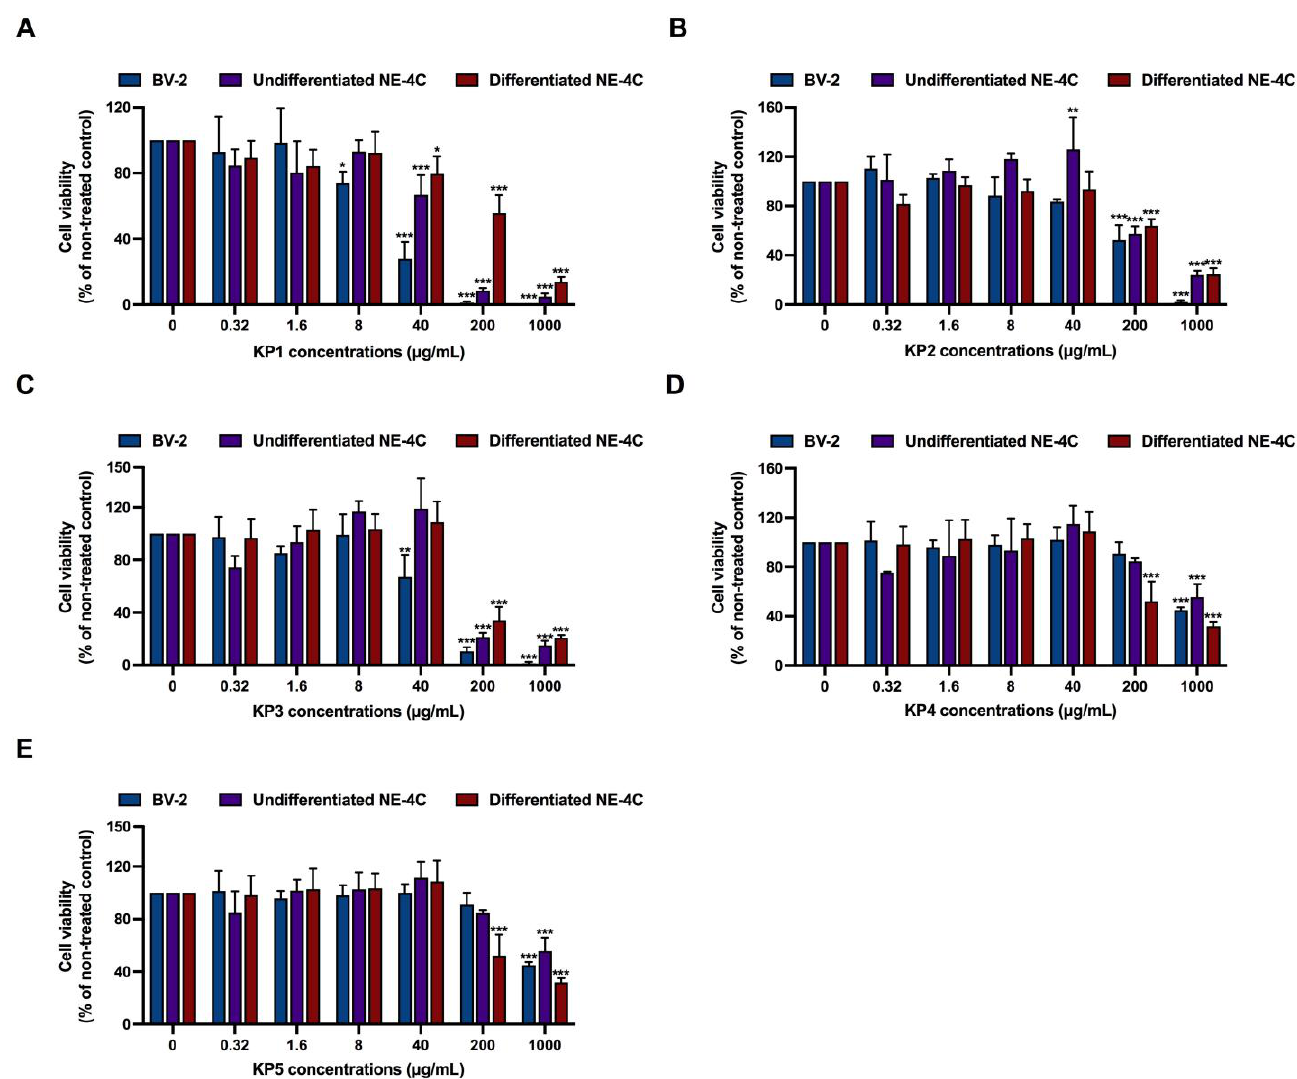
Figure 2. Cytotoxicity effects of K. parviflora extracts (KP1–KP5) on BV-2 cells, undifferentiated NE-4C and differentiated NE-4C measured by XTT assay. ( A ) KP1 fraction, ( B ) KP2 fraction, ( C ) KP3 fraction, ( D ) KP4 fraction, and ( E ) KP5 fraction. The values are mean ± SD of three independent experiments and statistical significance was analyzed against untreated control (0 µM) of each cell line by one-way ANOVA followed by Tukey’s test. *, p < 0.05, **, p < 0.01, ***, p < 0.001.